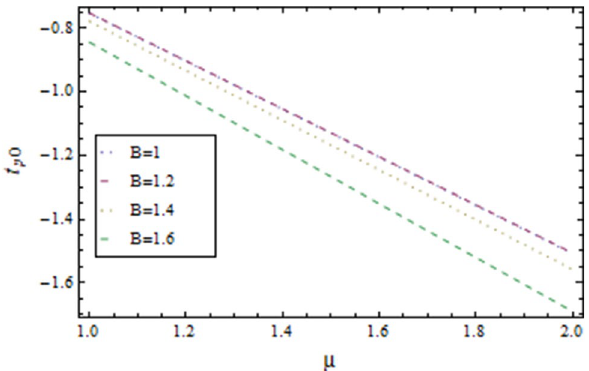
Figure 12. Shear Stress for M = 0.0005, (cid:31) = 0.1and A = 1 using OHAM.